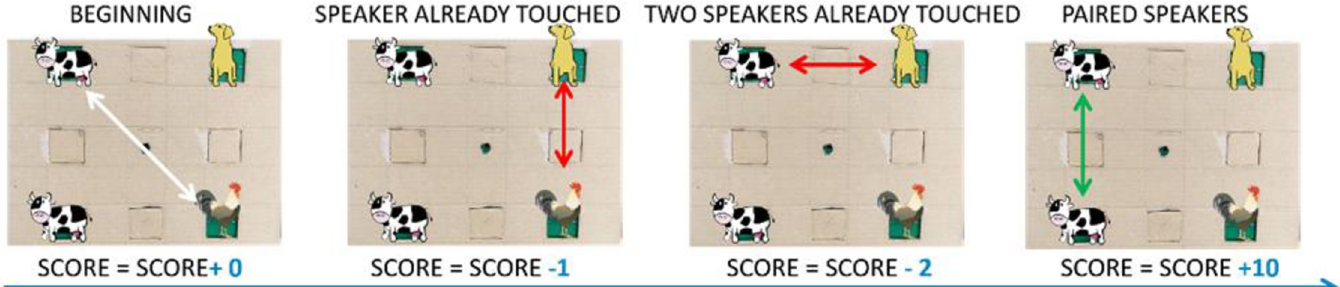
Fig 6. Example of score calculation. The score is an index that decreases when the child returns to the speakers previously touched. When the child touches two speakers for the first time, the score equals 0. If they have already touched one or both the speakers, the score decreases by 1 or 2, respectively. When a pair is found, the score increases by 10. In the example, if the starting value were equal to 0, the final score would have been: 0–1–2 + 10 = 7. Depicted animals were downloaded from a royalty- free images web archive